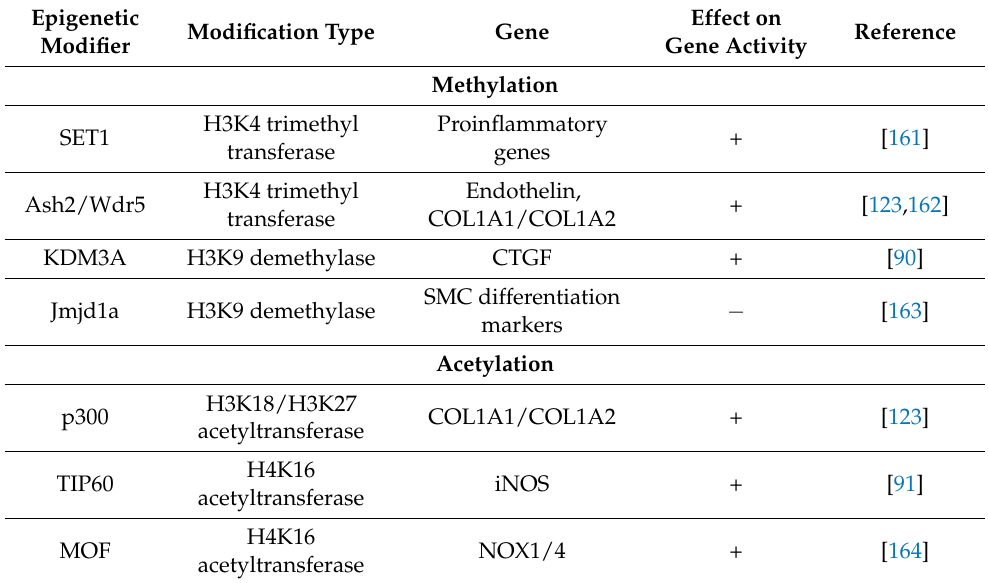
Table 3. MRTF epigenetic